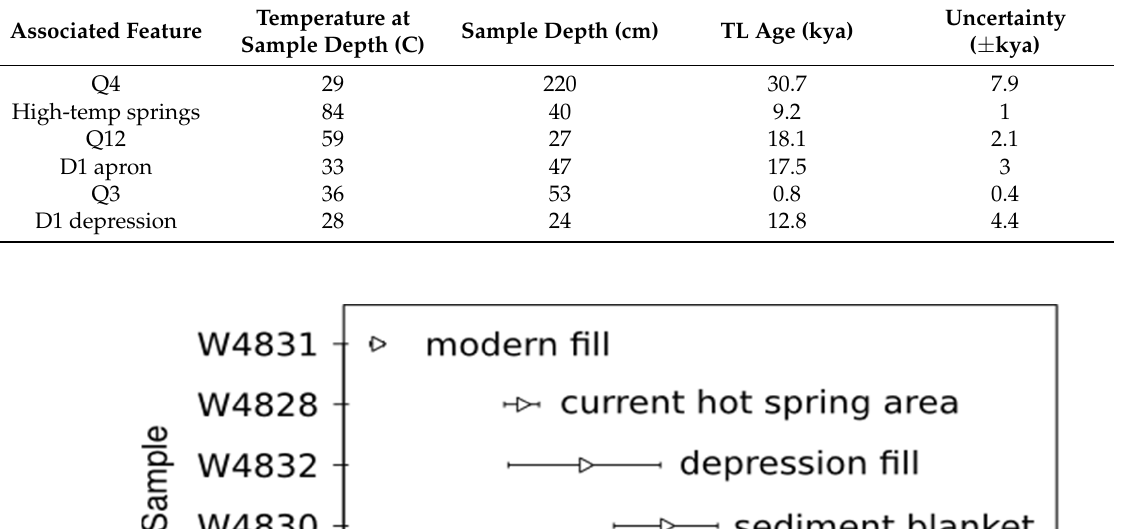
Table 2. Thermoluminescence dates from Mickey Springs, ordered on the left by Sample ID #. Sample descriptions and limitation are included in Appendix A: TL Dating. Samples processed by David M. Price, Thermoluminescence Laboratory, University of Wollongong, Australia.